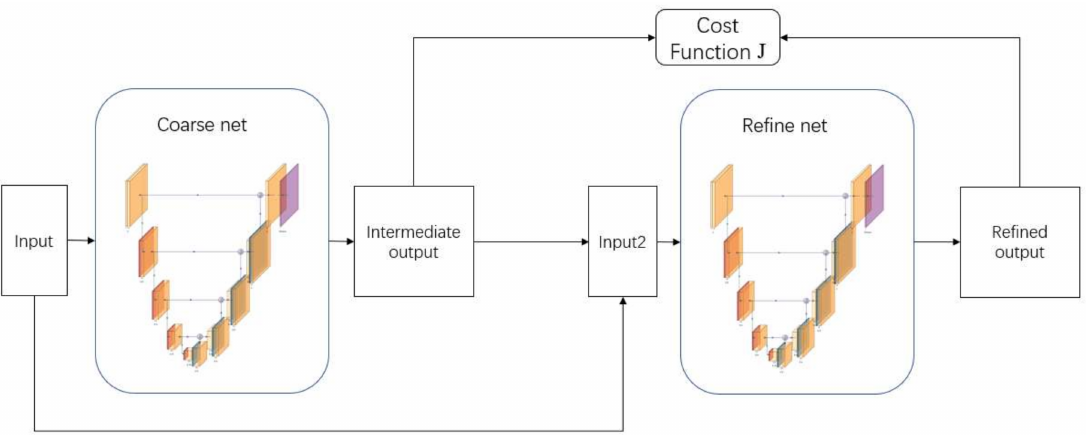
Figure 6. The architecture of the coarse-to-fine